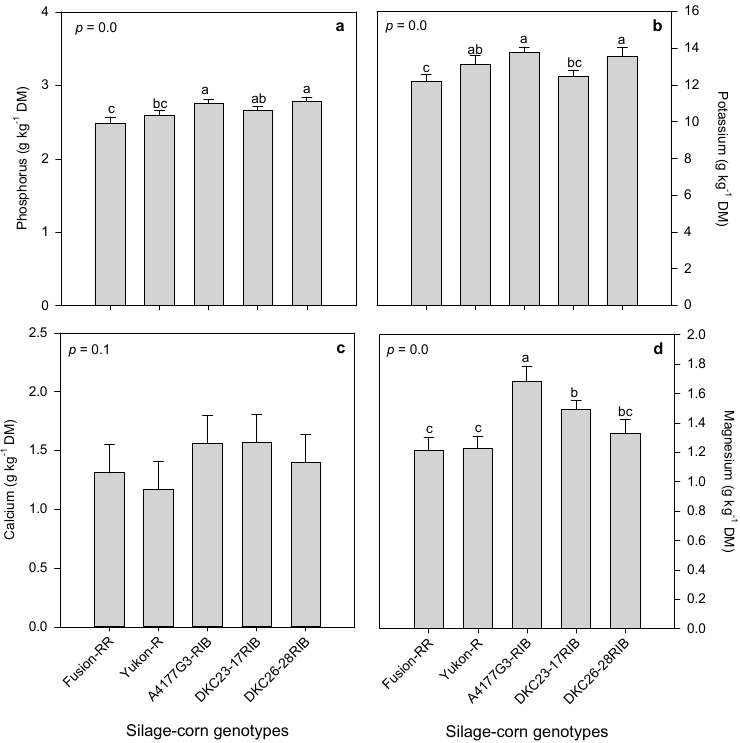
Figure 3. Variations in forage minerals among silage-corn genotypes: 3( a ) phosphorus, 3( b ) potassium, 3( c ) calcium, and 3( d ) magnesium. Each bar represents mean of three replications ± SE. 229